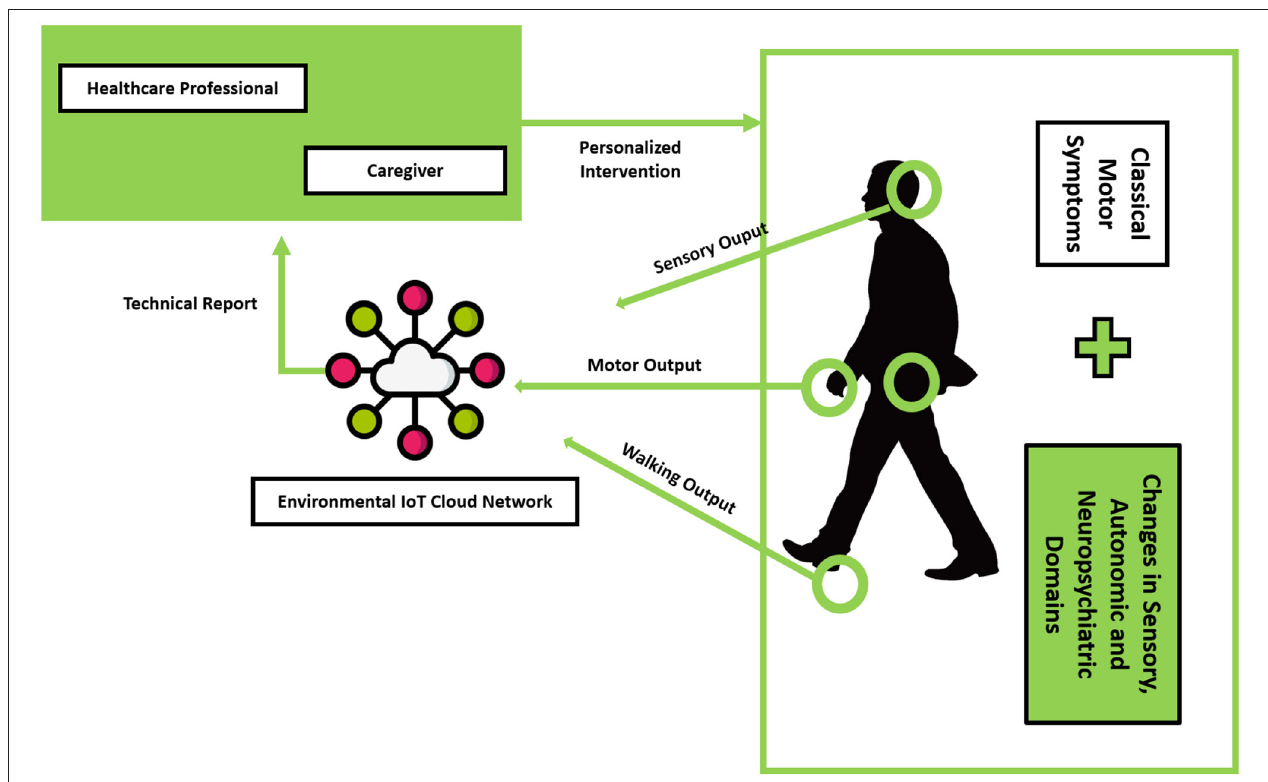
FIGURE 2 | PD management using Environmental IoT Cloud